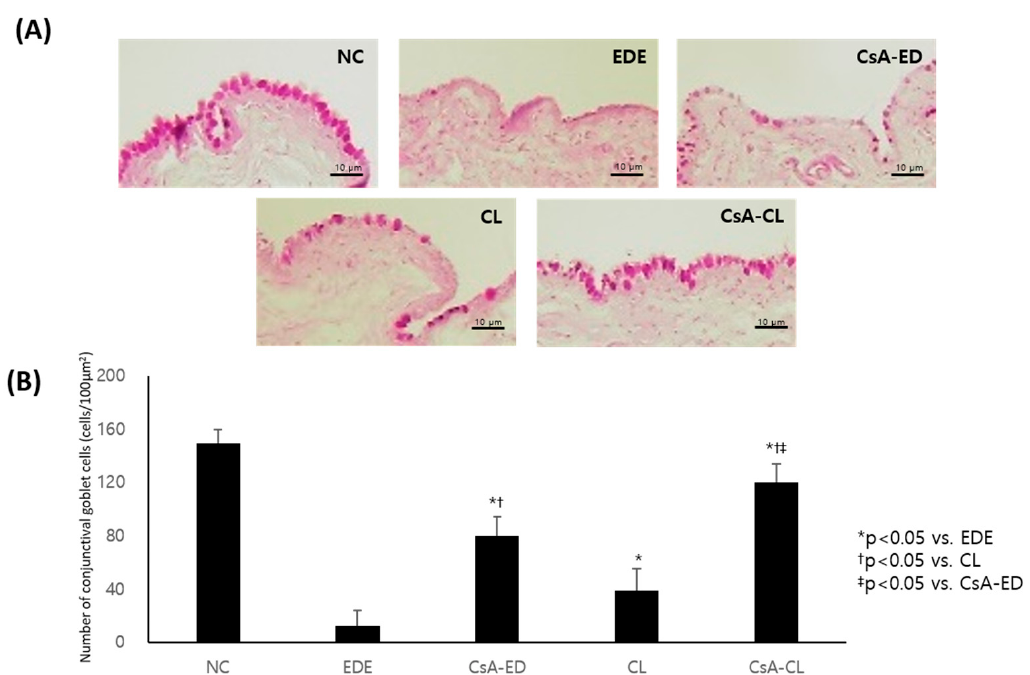
Figure 6. The representative images of PAS-stained conjunctival tissues obtained from all groups at 14 days ( A ) and the mean density and SD of conjunctival goblet cells in the samples presented in cells/100 μ m 2 ( B ). NC: normal control; EDE: experimental dry eye; CsA-ED: cyclosporine A eye drop; CL: contact lens; CsA-CL: cyclosporine A-loading pH-responsive contact lens.